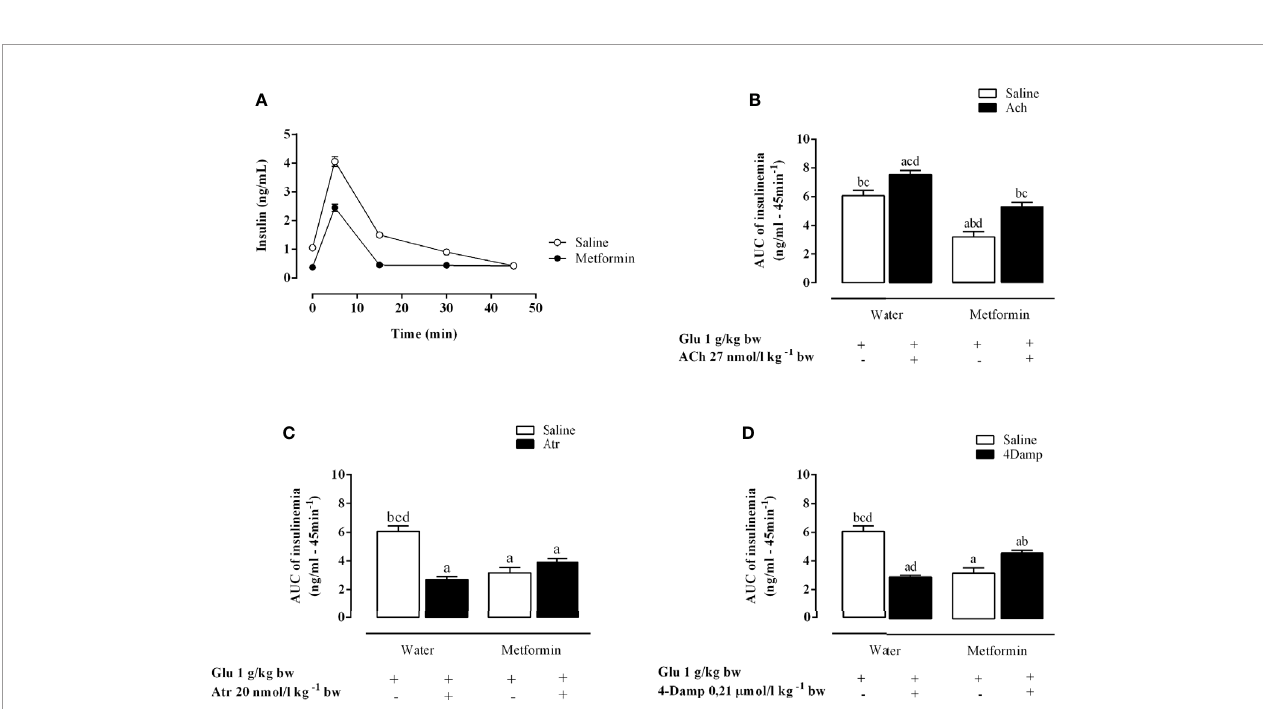
FIGURE 2 | Effects of muscarinic receptor agonist and antagonists on insulinemia throughout the intravenous glucose tolerance test (ivGTT). (A) Effect of metformin treatment on insulinemia during the ivGTT. (B – D) show the area under the insulinemia curve during IVGTT induced by glucose load after pretreatment with Ach, Atr and 4-DAMP, respectively. The bars represent the mean ± SEM from 8 – 12 rats for each treatment, and letters over the bars represent the statistically signi fi cant differences using one-way ANOVA (p <0.0001) among the